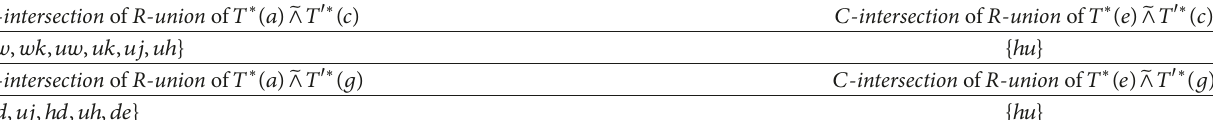
Table 7: 𝐶 -intersection of 𝑅 - union of 𝐴∧ E 𝐵 correlation